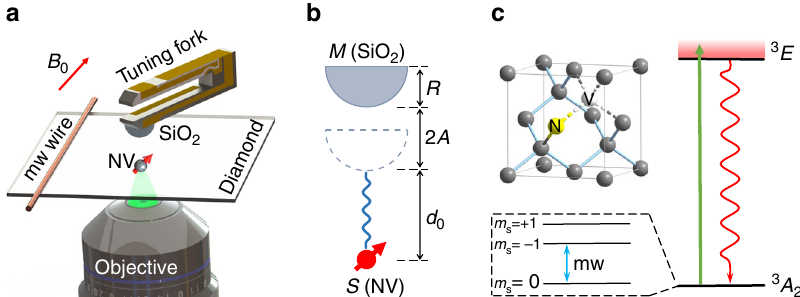
Fig. 1 Experimental setup and the quantum sensor. a Schematic experimental setup. An NV center in diamond, which is labeled as NV, is used to search for the monopole – dipole interaction with nucleons. The nucleons are provided by a fused silica half-ball lens, which is labeled as SiO 2 . The half-ball lens is placed on a tuning fork actuator of an AFM. A static magnetic fi eld B 0 is applied along the symmetry axis of the NV center. b Schematic experimental parameters. The electron spin and the half-ball lens are denoted as S and M , respectively. The radius of M is R . M is located right above S and driven to vibrate with amplitude A . The distance between S and the bottom of M is d 0 when M vibrates to the position nearest S . c Atomic structure and energy levels of the NV center in diamond. The NV center consists of a substitutional nitrogen atom with an adjacent vacancy cite in the diamond crystal lattice. The ground and excited states are denoted as 3 A 2 and 3 E . The NV center can be excited from 3 A 2 to 3 E by a laser pulse, and decays back to 3 A 2 emitting photoluminescence. The optical transitions are used to initialize and readout the spin state of the NV center. The spin states m S ¼ 0 j are encoded as a quantum sensor. The state of S can be manipulated by microwave